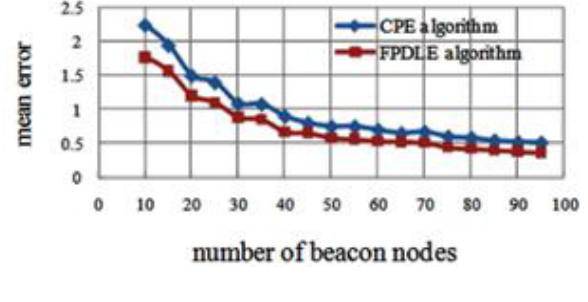
Figure 12. Number of Beacon Nodes vs. Mean